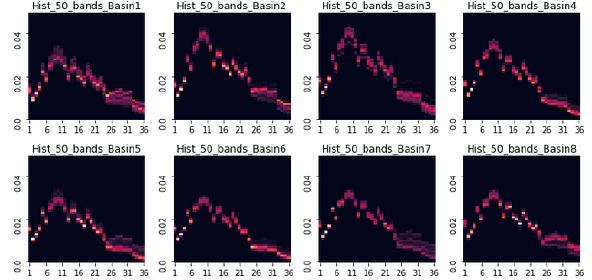
Figure 2. Spectral reflectance signatures of the basins